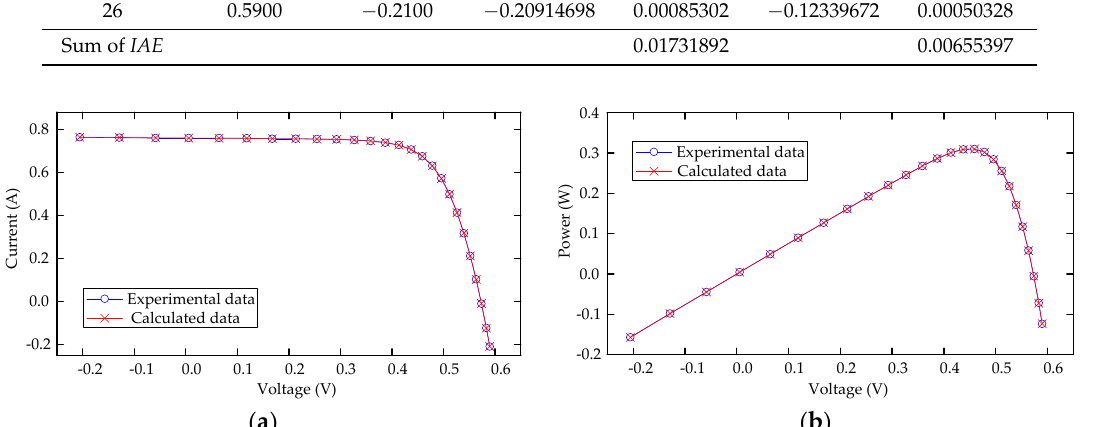
Figure 7. Comparisons between the experimental data and calculated data obtained by the proposed ImCSA for the DDM of RTC France silicon solar cell: ( a ) I-V characteristics; ( b ) P-V characteristics.